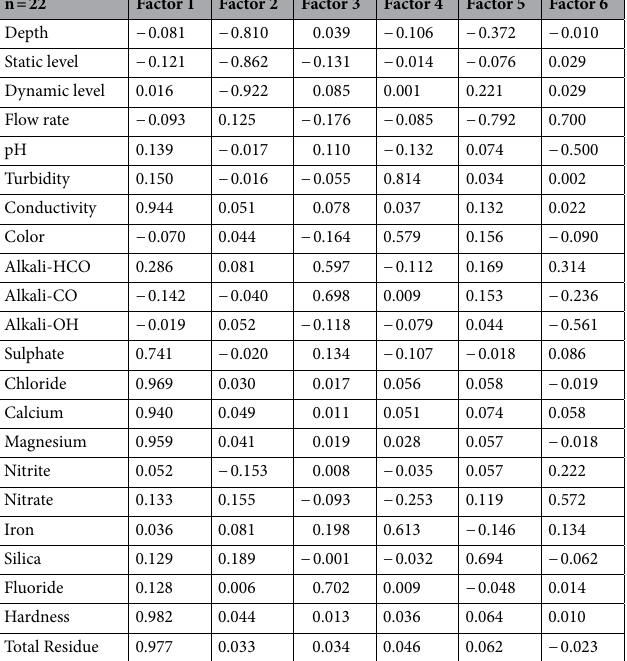
Table 5. Factorial Loads after Normalized Varimax